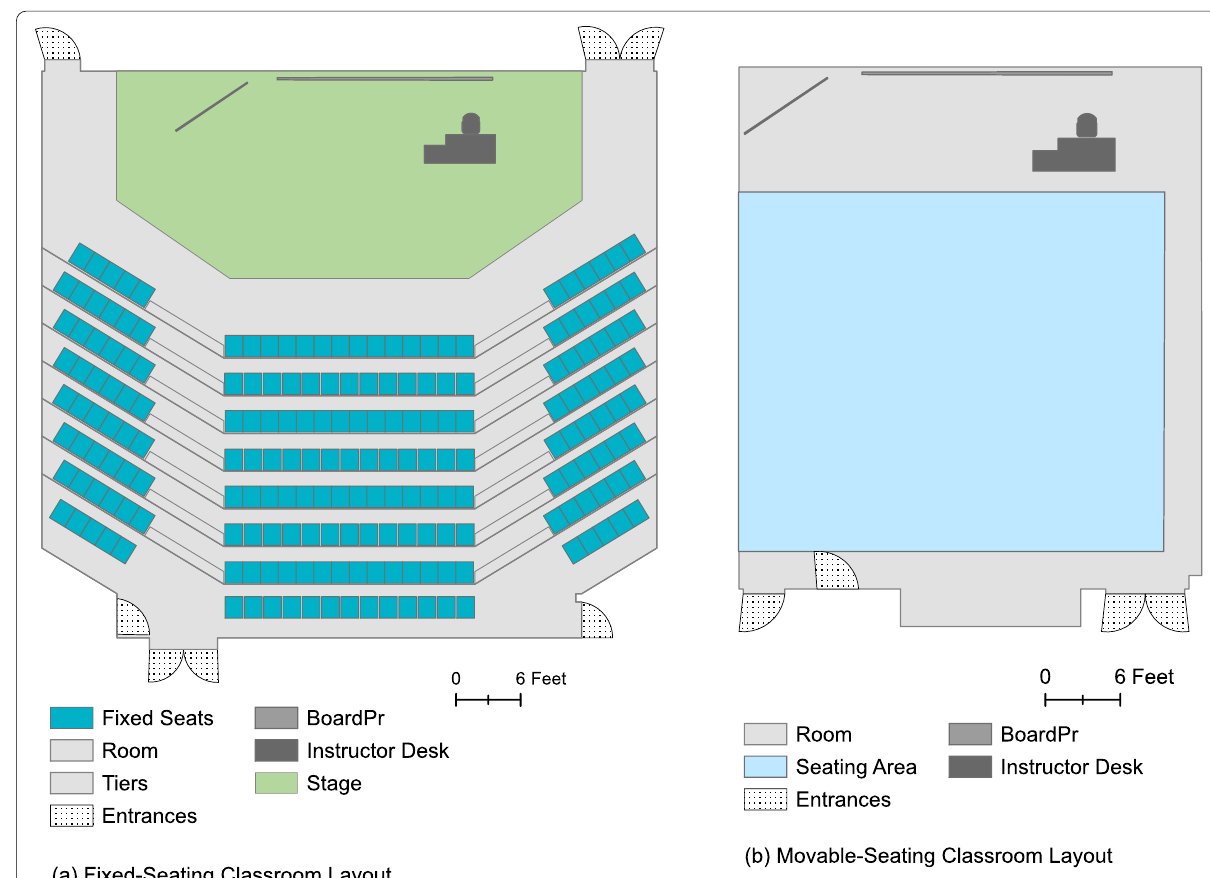
Fig. 4 Spatial data created using DWG and JPEG files for